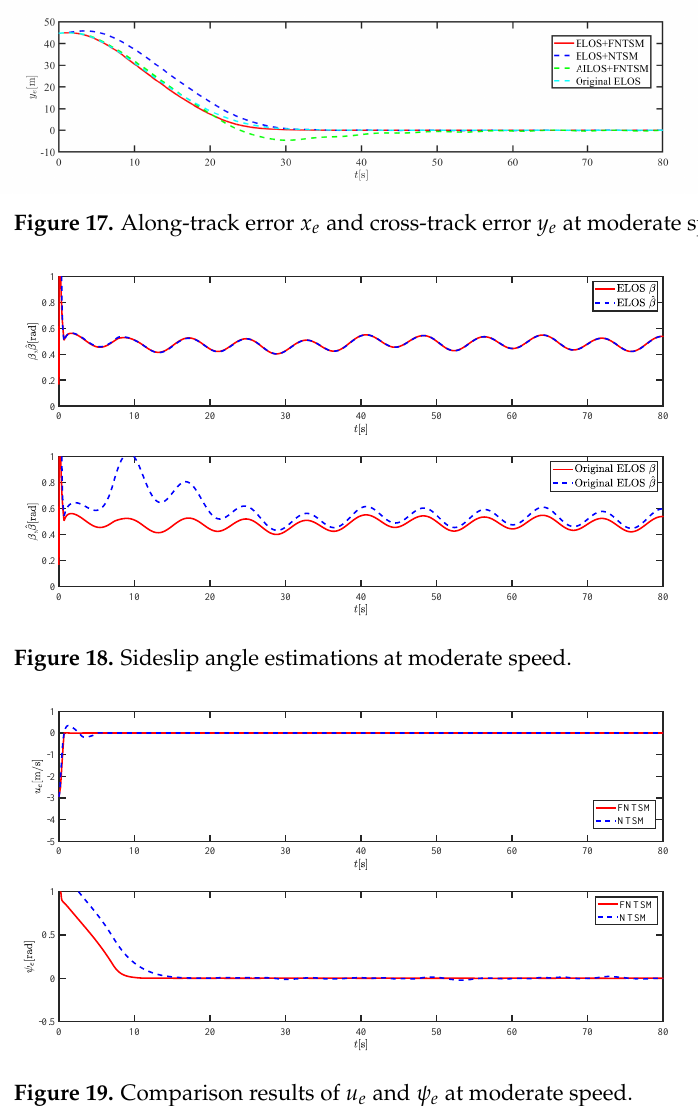
Figure 19. Comparison results of u e and ψ e at moderate